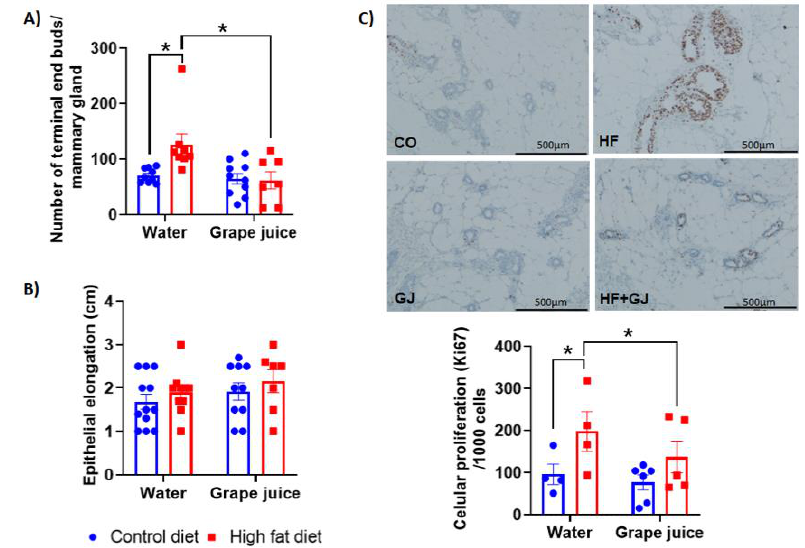
Figure 1. Mammary gland morphology in 7-week-old female rat o ff spring of dams fed control or high fat diet (HFD) during pregnancy and lactation. These dams either received tap water or grape juice. Quantitated data and Western blots are shown. ( A ) Number of terminal end buds (TEBs) per mammary gland. ( B ) Epithelial elongation (in cm) of mammary gland. Photomicrography (40 × ) of Ki67 staining and quantification of cell proliferation ( C ) in mammary glands of female o ff spring from the di ff erent groups. * Statistically significant di ff erence ( p ≤ 0.05) according to two-way ANOVA followed by Sidak′s test. The data are expressed as the mean ± SEM.